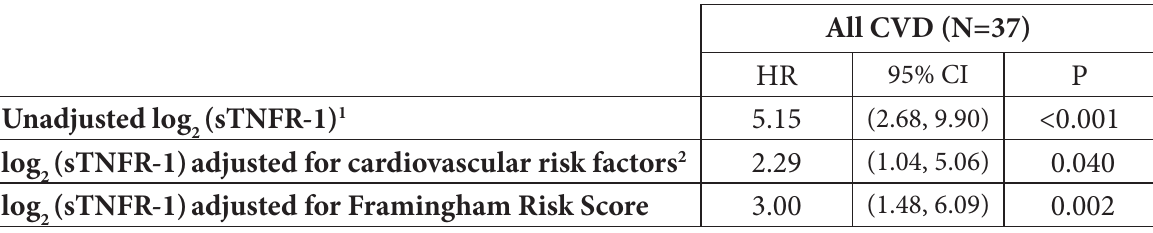
Table 2. Cox proportional-hazards regression models for all CVD for the binary logarithm of